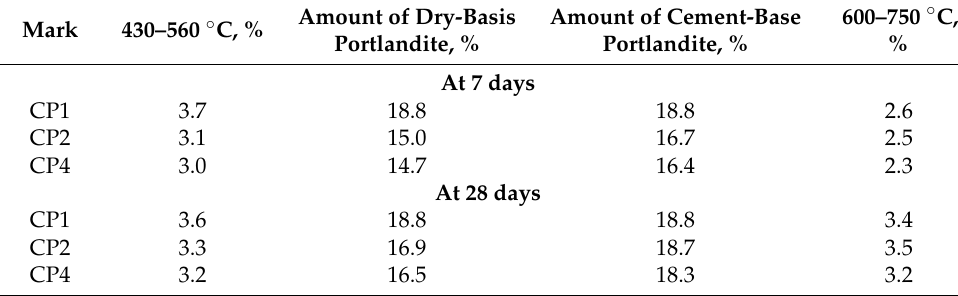
Figure 10. DTA and TG results after 28 days of curing. Table 5. Mass loss results for the relevant temperature ranges.